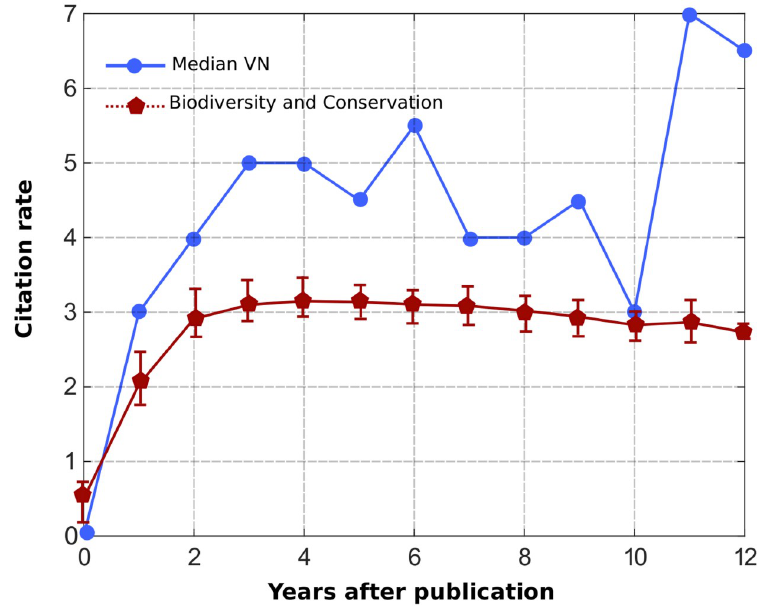
Fig 4. Time-dependent median value of the Vigie-Nature articles citation rate. The median (in blue) is compared to the average citation rate of the articles in biodiversity and conservation from WoS (in red, sample size: 60847 papers).